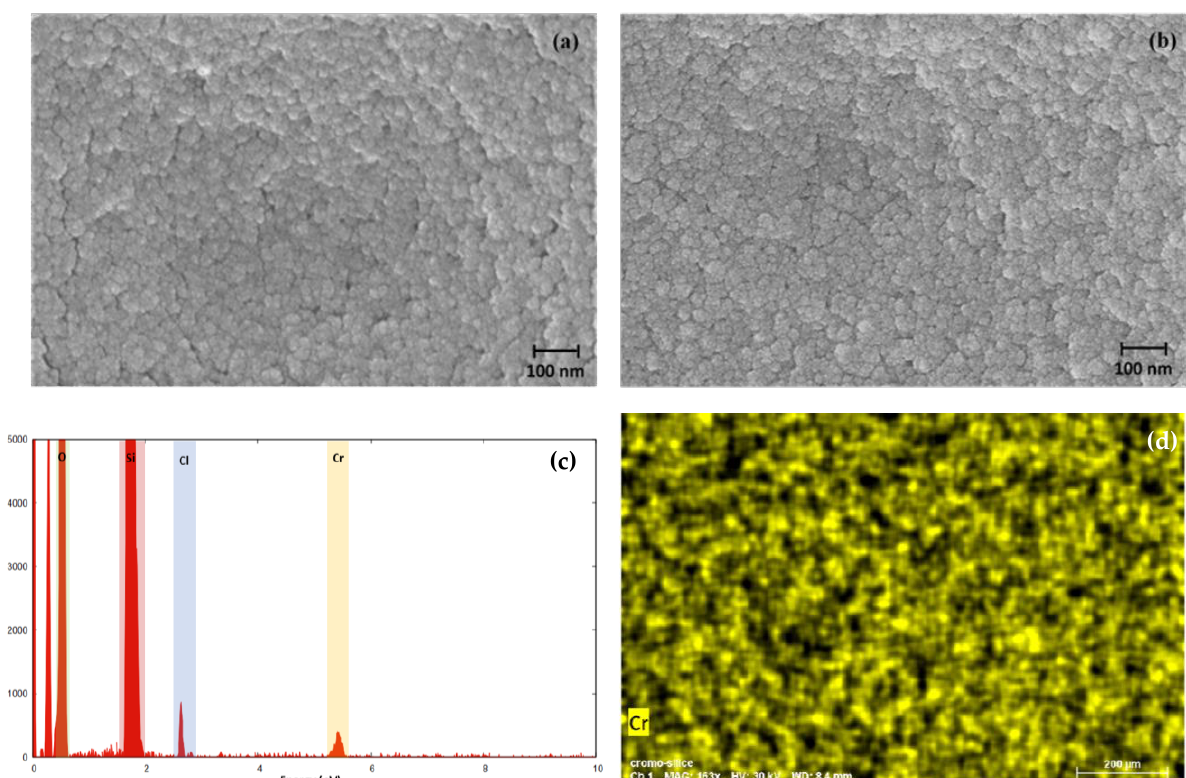
Figure 4. SEM images of silica-based xerogel ( a ) before and ( b ) after the absorption of Cr(VI), ( c ) EDX spectrum of the silica-based xerogel after the adsorption of Cr(VI) and ( d ) map distribution image for Cr.